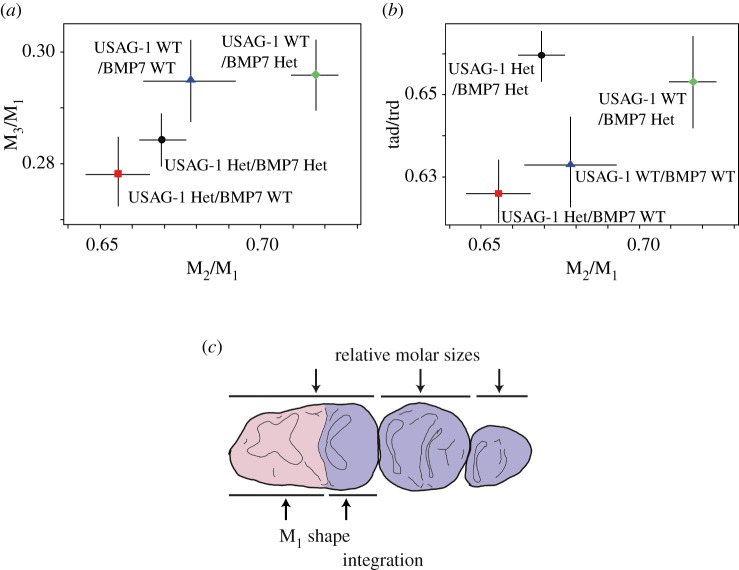
Difference in relative molar sizes and M1 shape (relative trigonid and talonid size) between mice of different Usag-1 and Bmp7 genotypes. (a) Plots of M2/M1 versus M3/M1. Het, hetero-deficient; WT, wild-type. Plots are averages of each genotype and two-dimensional bars indicate the standard error. (b) Plots of M2/M1 versus tad/trd. Our results suggest that Bmp7 Het (i.e. a decrease in BMP7) generates larger M2/M1 and tad/trd scores. (c) Schematic illustration of mouse dentition for the integration of relative molar sizes and M1 shape caused by BMP7.